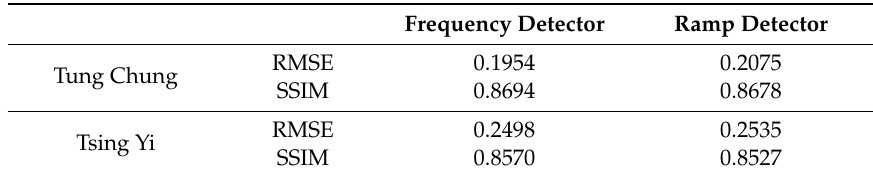
Figure 9. Building layover detection of Tsing Yi: ( a ) optical images; ( b ) frequency result in the range direction obtained by the proposed method; ( c ) result of the ramp detector; ( d ) artificial extracting result; ( e ) final result of the proposed method; and ( f ) final result of ramp detector. Table 2. Performance assessment for two areas.